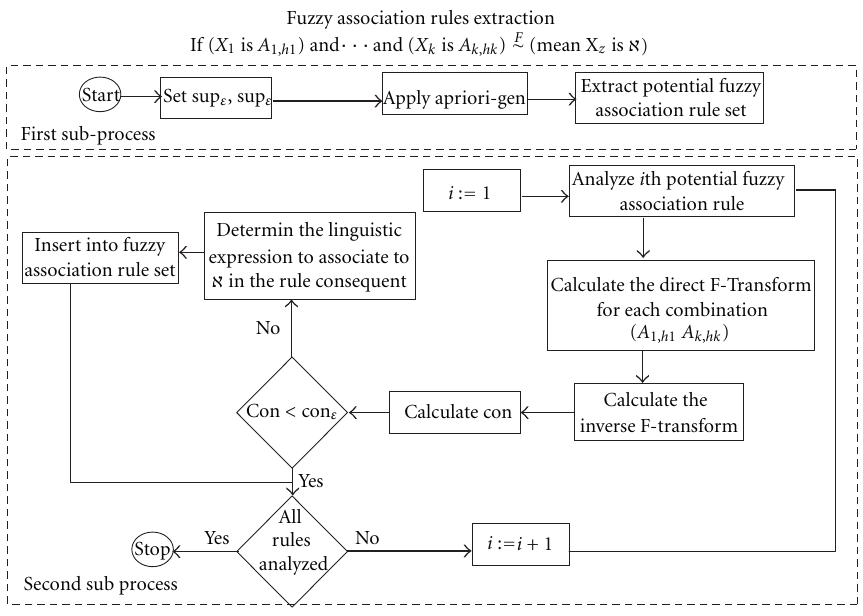
Figure 5: Extraction process of fuzzy association